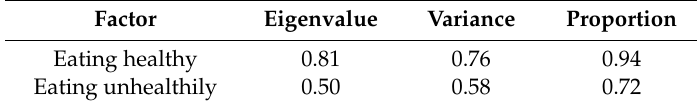
Table A1. Principal factors extracted in the Exploratory Factor Analysis.